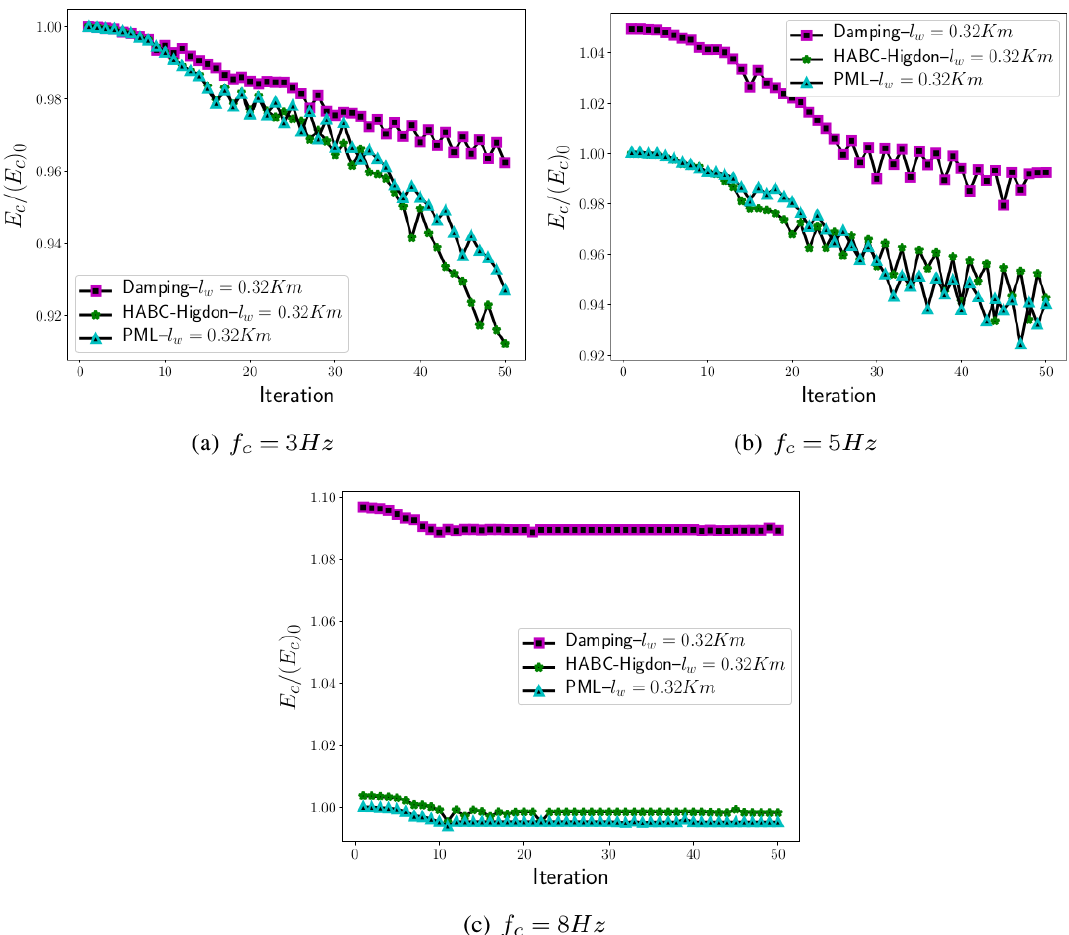
Figure 18. Comparisons of the misfit values E c /(E c ) 0 for velocity model computation that is then matched with Marmousi, where the peak of frequency is f 0 = 15Hz, and a multiscale approach in frequency (Bunks et al., 1995) is employed. (E c ) 0 is computed at the first iteration, which is the minimal velocity error given by the employment of the damping, HABC-Higdon, and PML methods.